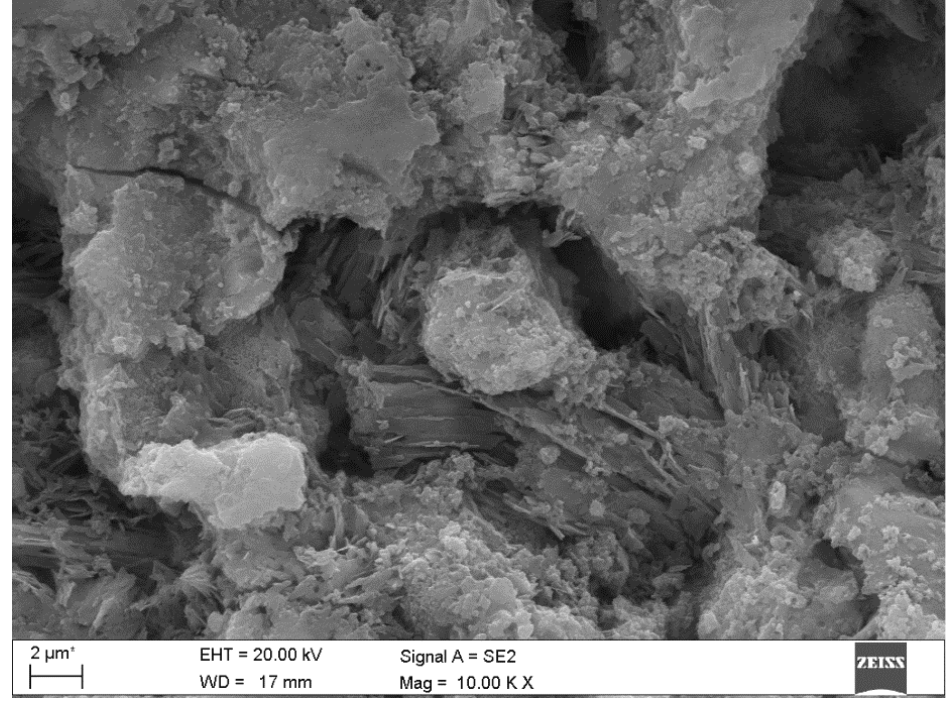
Figure 11. Friedel’s salt flake phase in the center of the photomicrograph taken for sample B-25 at a depth of 6.5 mm.